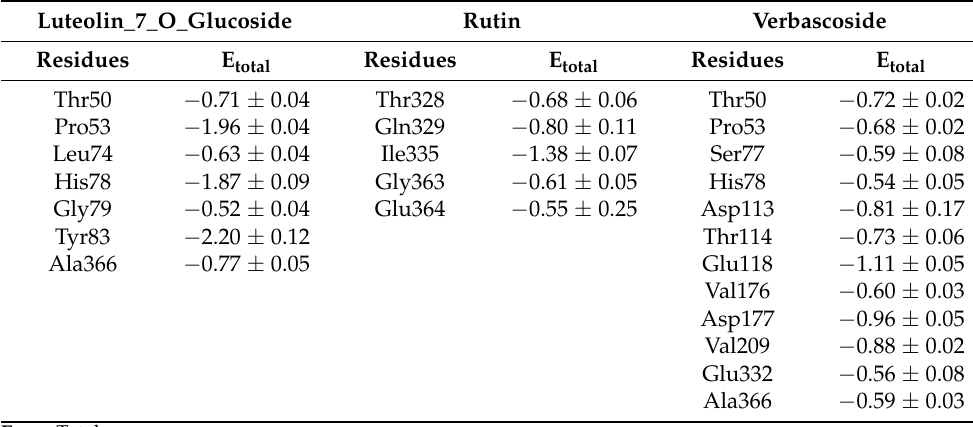
Table 7. Total binding energies (kcal mol − 1 ) of major energy contributors for the interaction of ligands with PKM2 calculated from